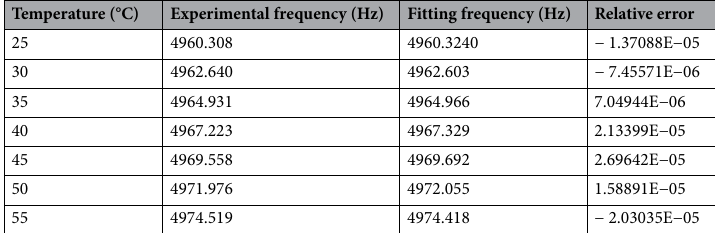
Table 3. The relative error in Eq. (2) for fitting the real